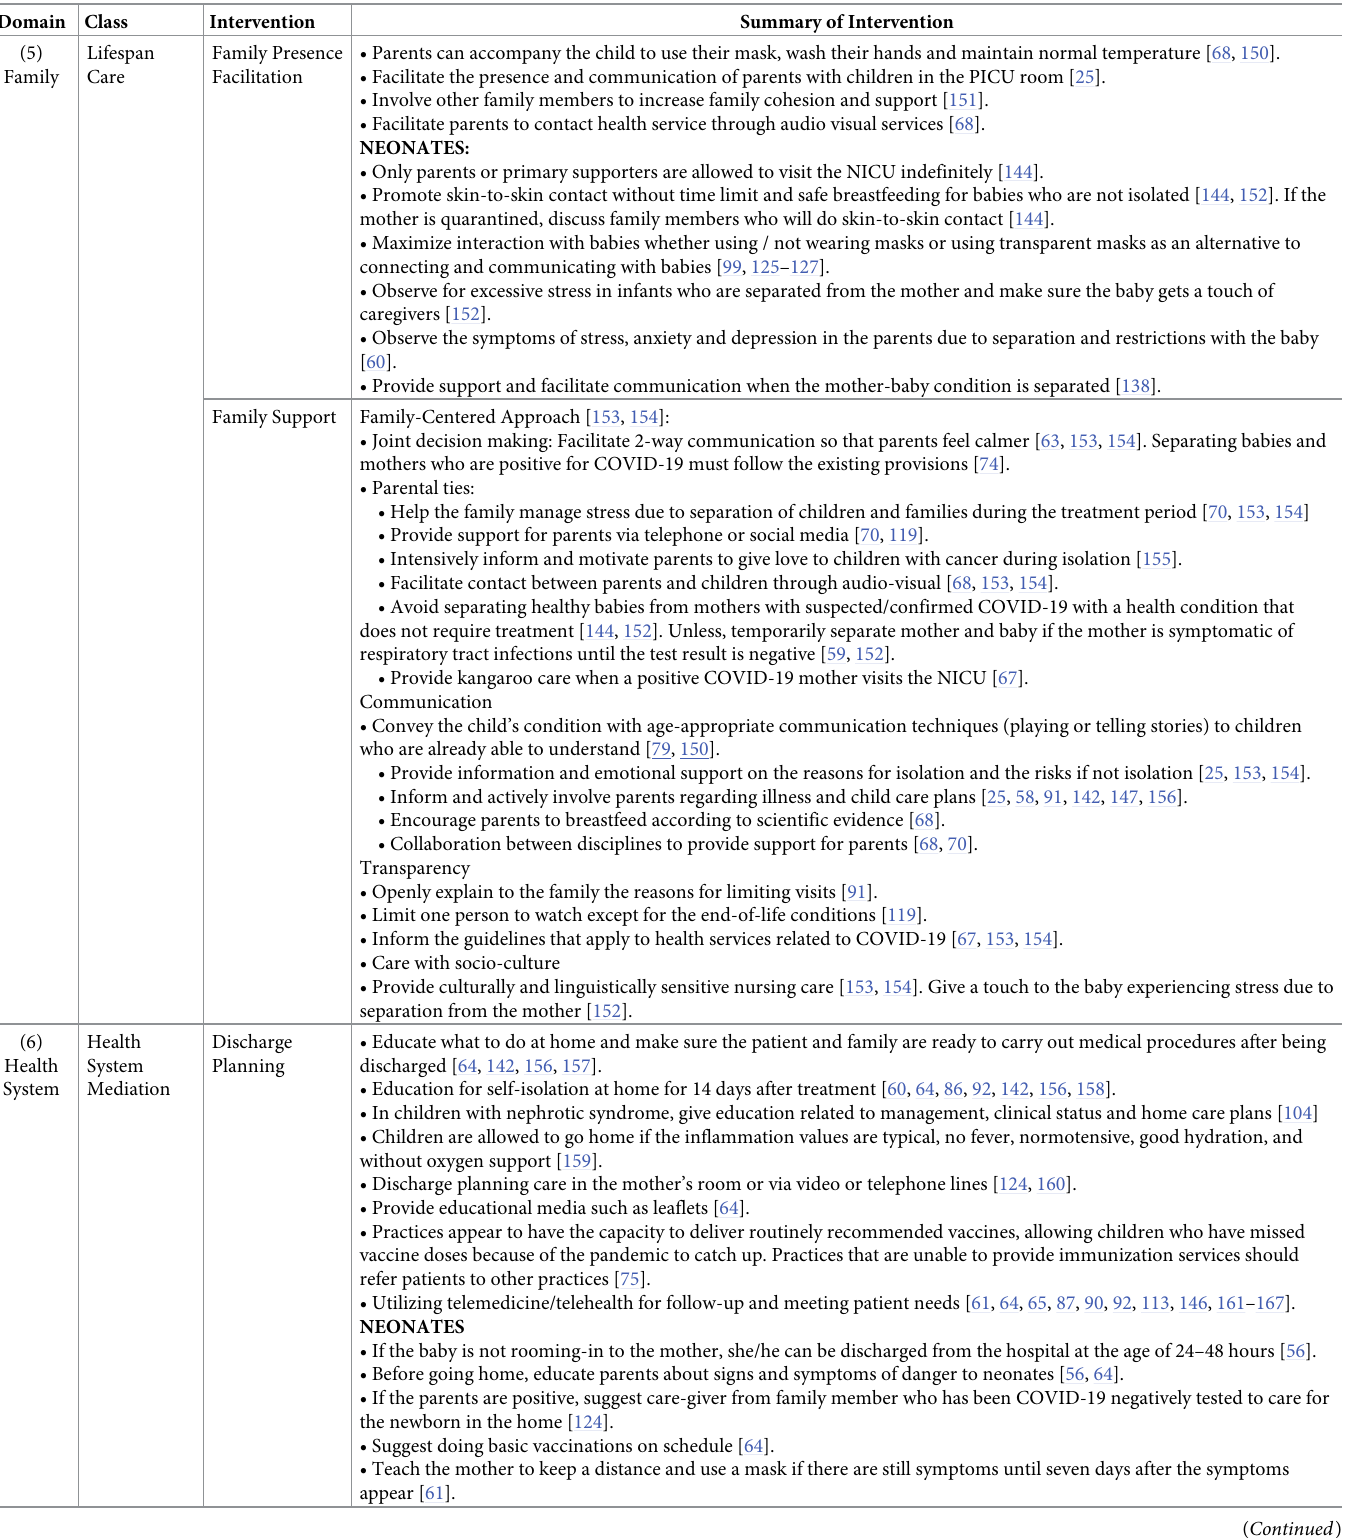
Table 3. Family and health system